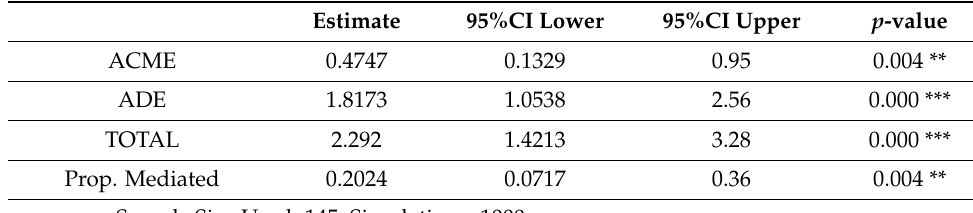
Table A3. Bootstrapping